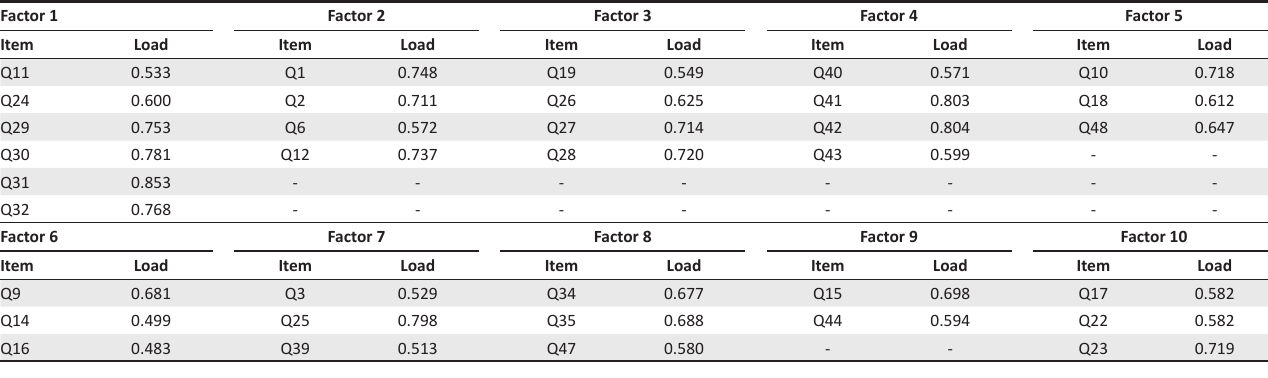
TABLE 1: Ten-factor solution.